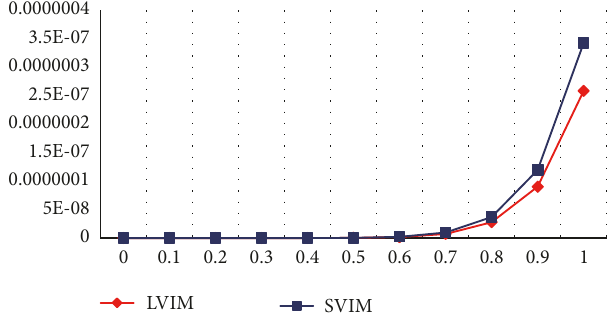
Figure 2: Graphs of the absolute errors for some values of 𝑡 with LVIM and SVIM for Example 2.